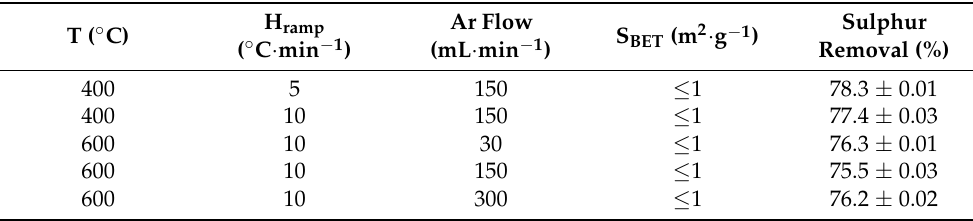
Table 10. Desulphurisation of waste cooking oil with orange waste biochars obtained under different